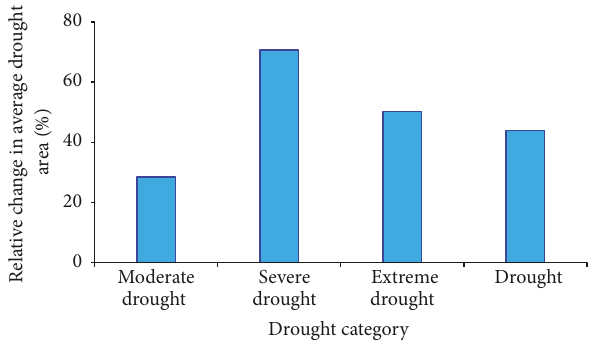
Figure 16: The percentage change in drought (%) from the reference period (1961–1990) to